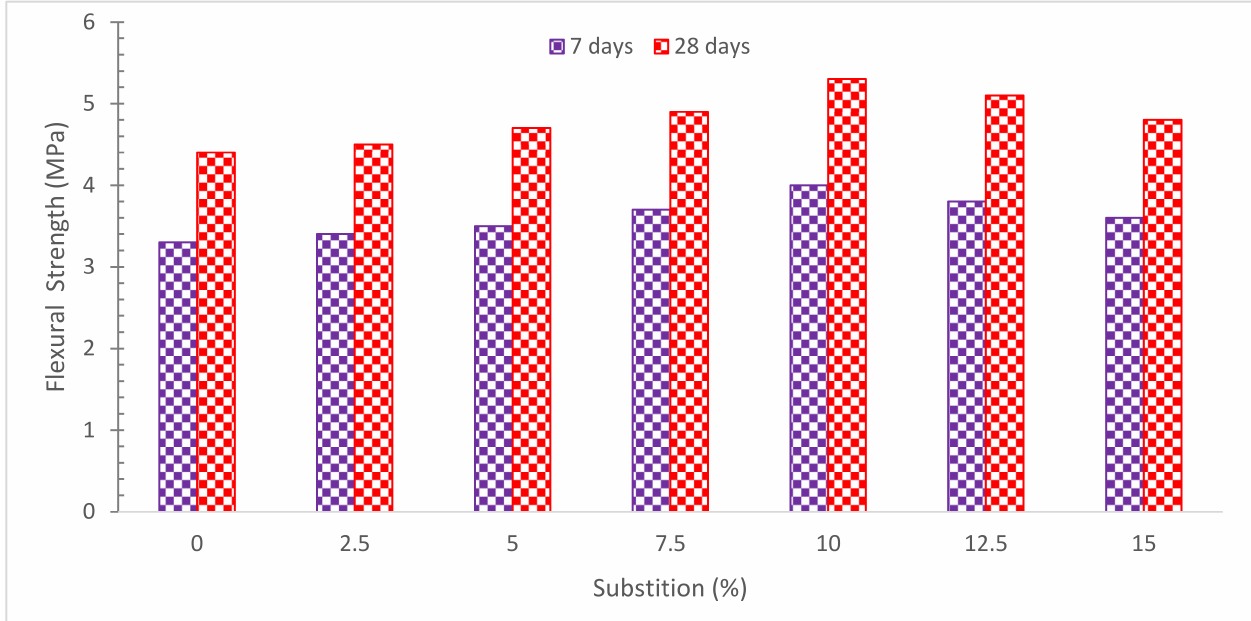
Figure 11. Flexural Strength: Data Source